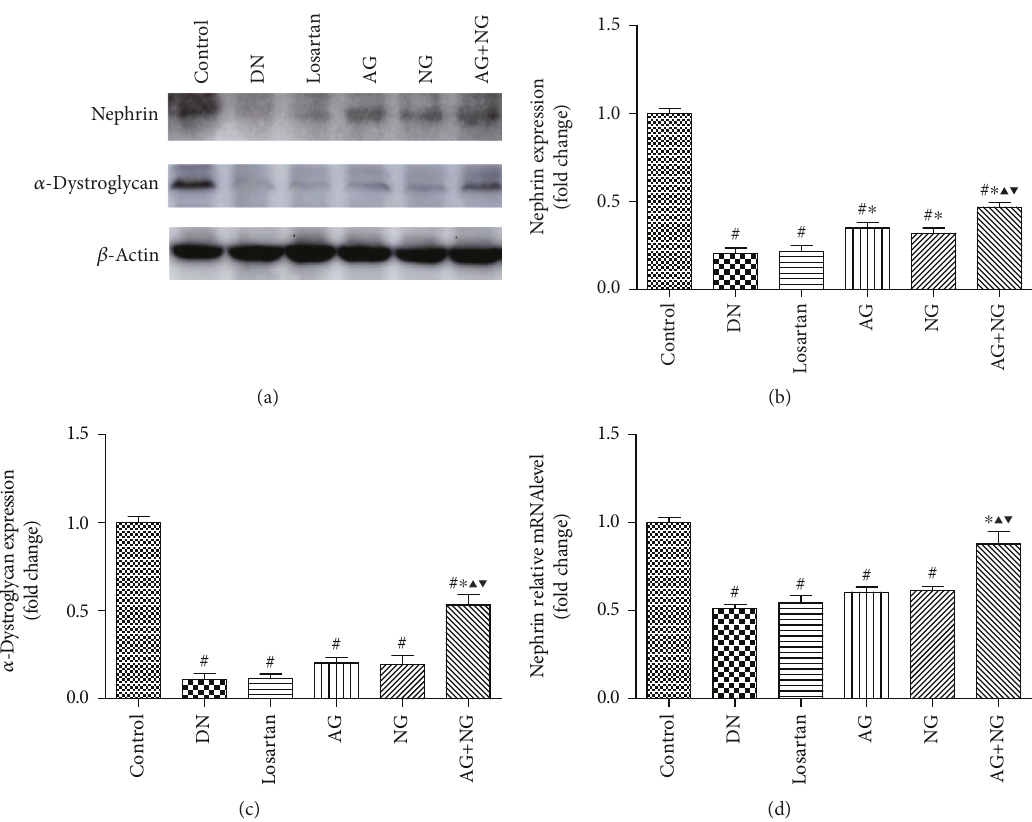
Figure 4: E ff ects of AG and NG on the levels of nephrin and α -dystroglycan detected by western blot and RT-PCR. Representative western blots for nephrin and α -dystroglycan (a) in the glomeruli of kidney sections. Semiquantitative analyses of western blot for nephrin (b) and α - dystroglycan (c). Glomerular relative mRNA level of nephrin (d). Control: normal control rats; DN: STZ-induced diabetic rats; losartan: DN rats treated with losartan; AG: DN rats treated with Astragalus membranaceus; NG: DN rats treated with Panax notoginseng; AG+NG: DN rats treated with Astragalus membranaceus plus Panax notoginseng. Results were expressed as the mean ± SD . # P < 0 05 vs. control group, ∗ P < 0 05 vs. DN group, ▲ P < 0 05 vs. AG group, ▼ P < 0 05 vs. NG